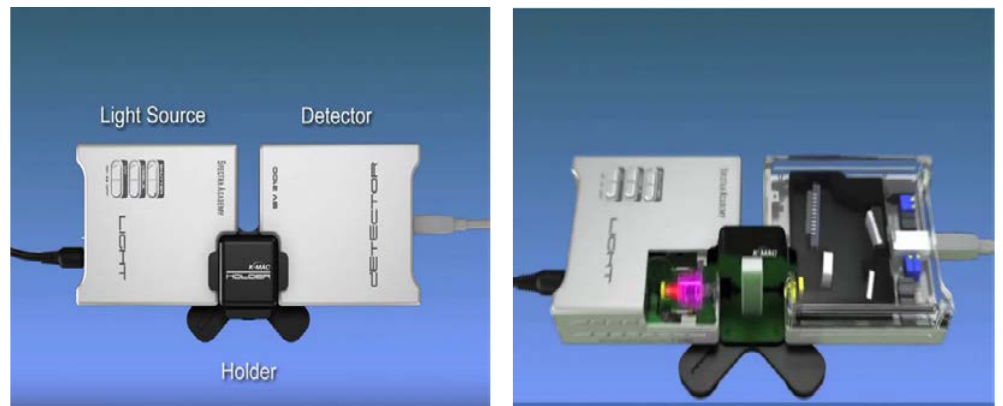
Fig. 3: The fluorescence spectrophotometer.